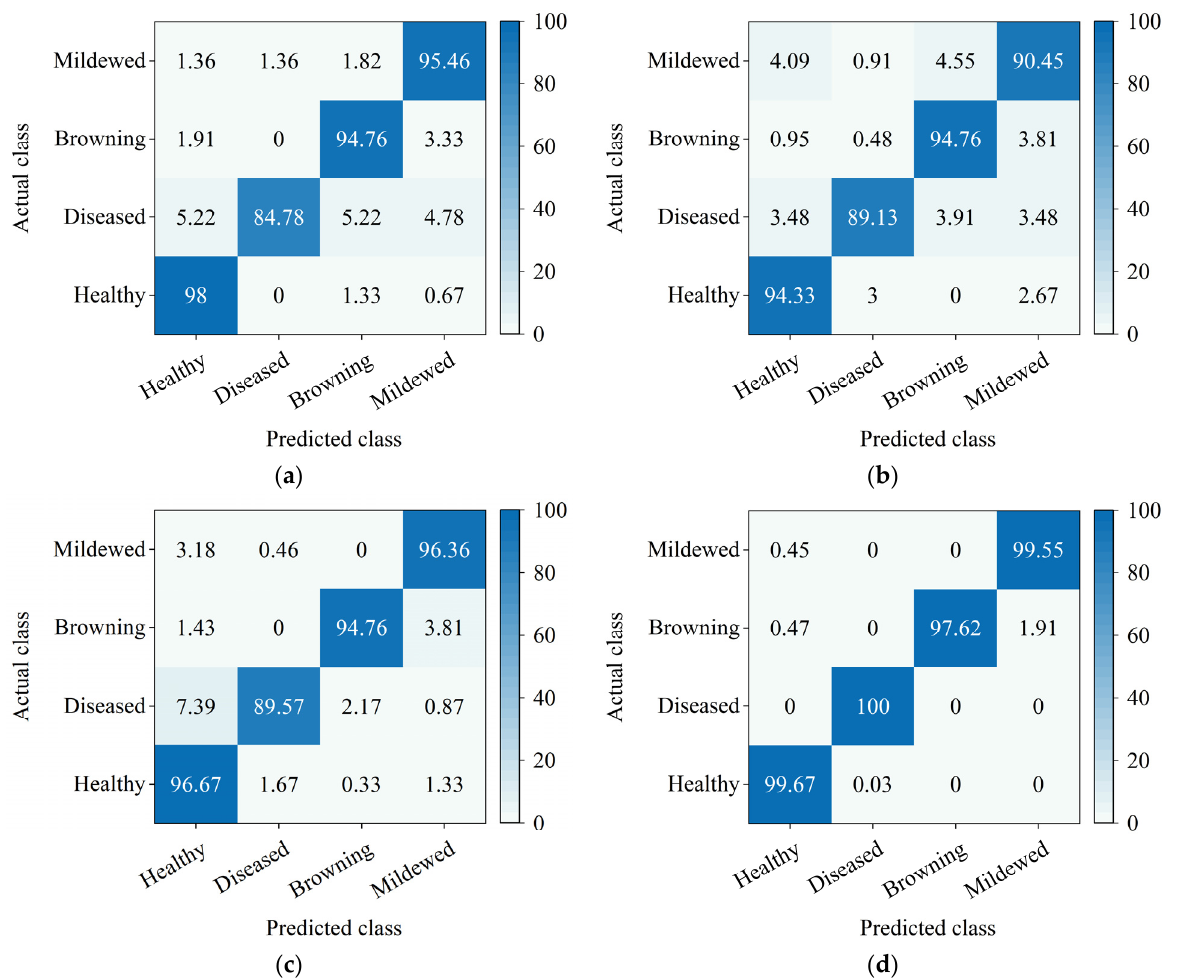
Figure 9. Confusion matrices of four models: ( a ) VGG19; ( b ) InceptionV3; ( c ) NASNetMobile; ( d )